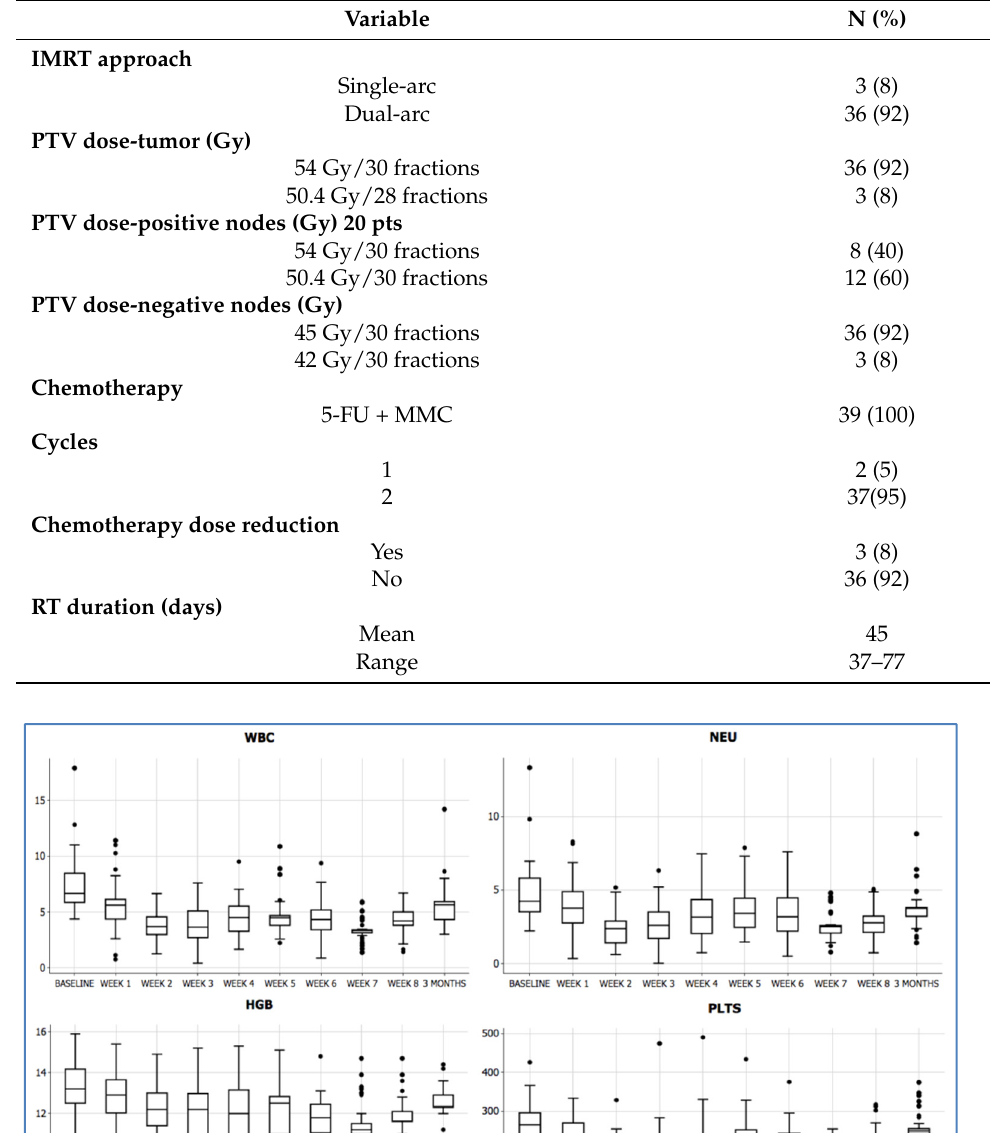
Table 2. Treatment characteristics.